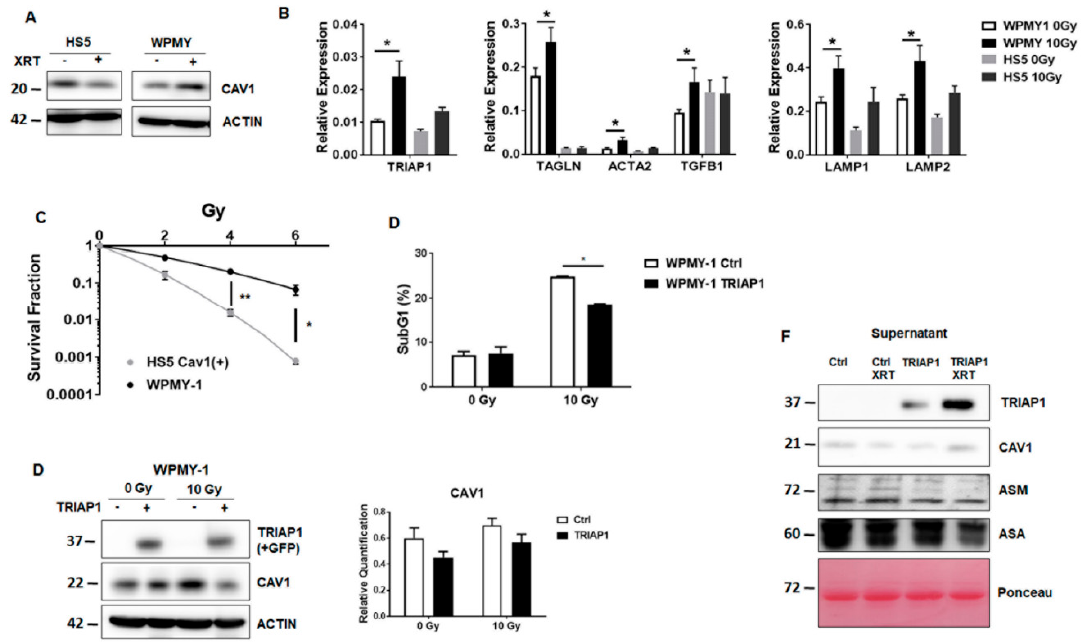
Figure 3. Characterization of the human prostate fibroblast cell line WPMY-1.